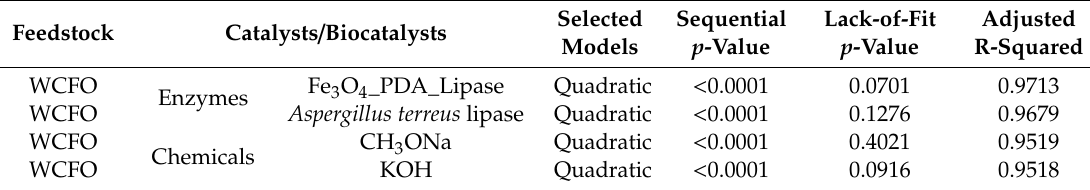
Table 1. Summary of selected quadratic